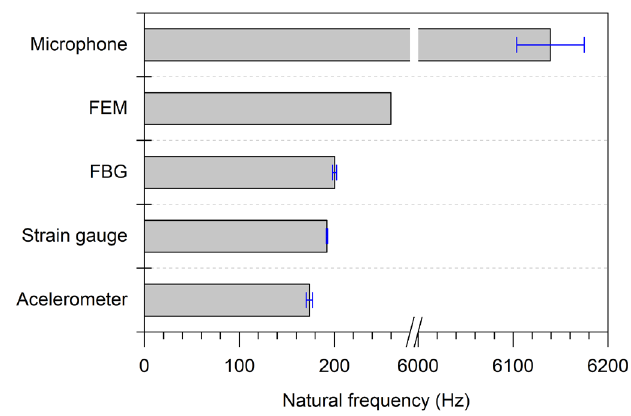
Figure 15. Natural resonant vibration frequencies